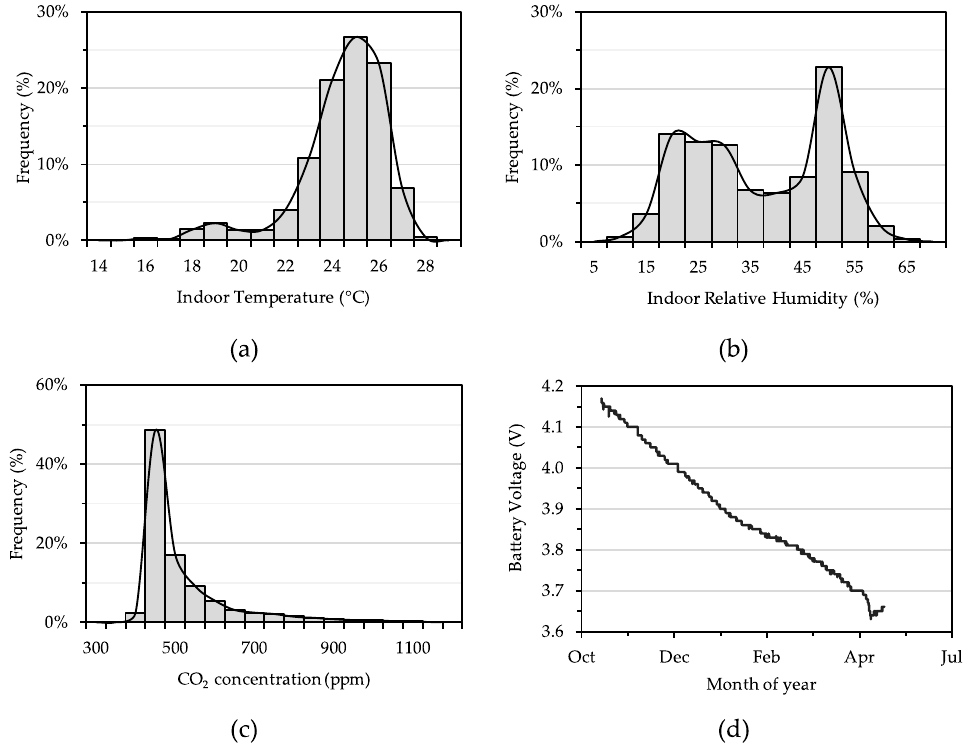
Figure 7. Histograms showing frequency distributions of 15-min averages of indoor ( a ) temperature, ( b ) relative humidity, and ( c ) CO 2 concentration, and ( d ) initial battery life (voltage over time) for a sensor node deployed in a research lab and office space for ~12 months.